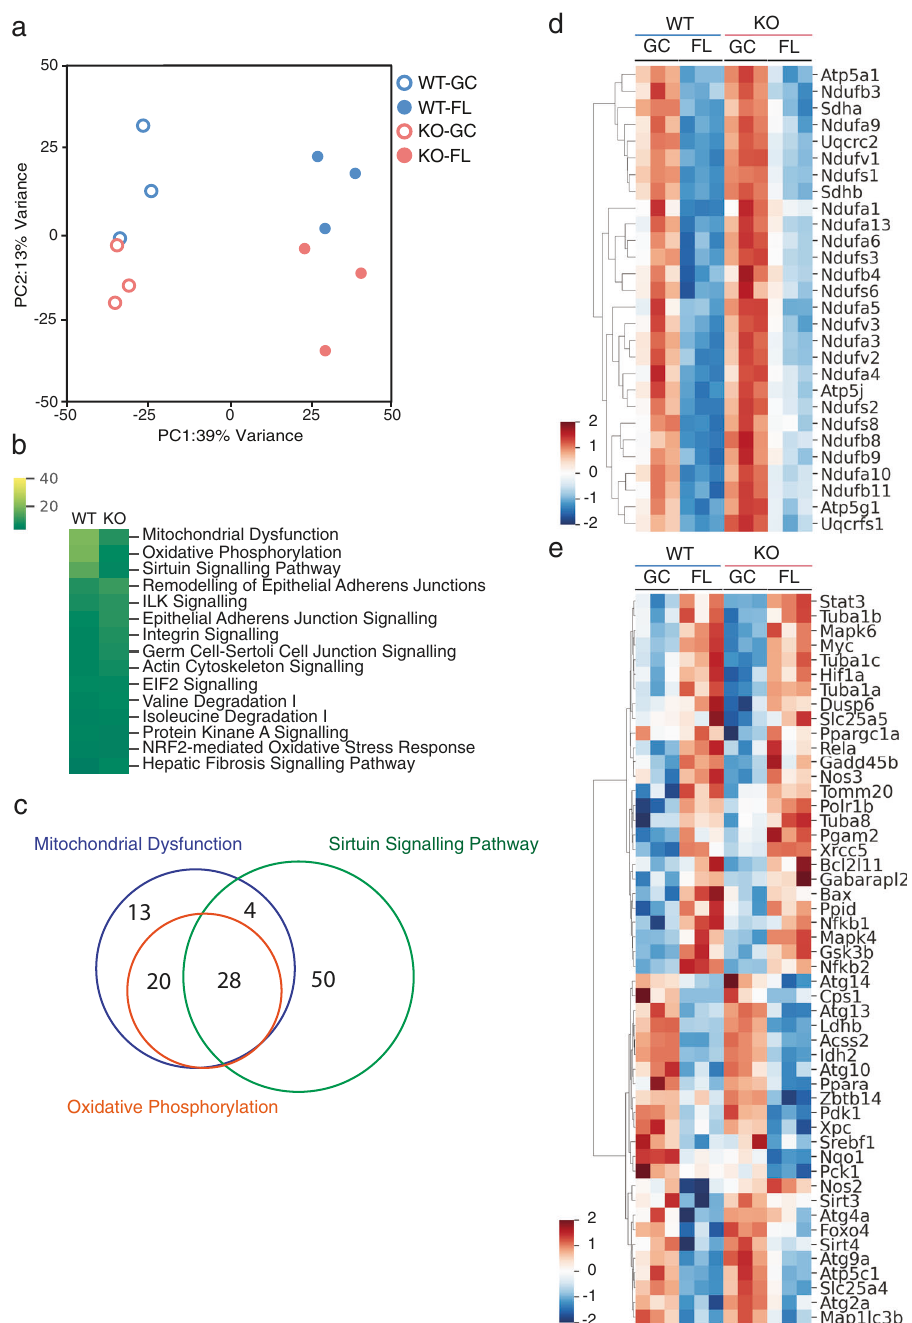
Fig. 2 Comprehensive analysis of gene expression by RNA sequence and pathway analysis. a PCA plot of overall gene expression in at least one comparison among WT-GC ( n = 3), WT-FL ( n = 3), KO-GC ( n = 3) and KO-FL ( n = 3) soleus muscles. b Top 15 pathway analysis of differentially expressed genes (DEGs) in WT (GC vs. FL) and KO (GC vs. FL). c Venn diagram of DEGs associated with each of the Mitochondrial Dysfunction, Oxidative Phosphorylation, and Sirtuin Signalling Pathway. d Heatmap of the expression of 28 genes overlapping in the three pathways. e Heatmap of the expression of 50 genes speci fi c to the Sirtuin Signalling